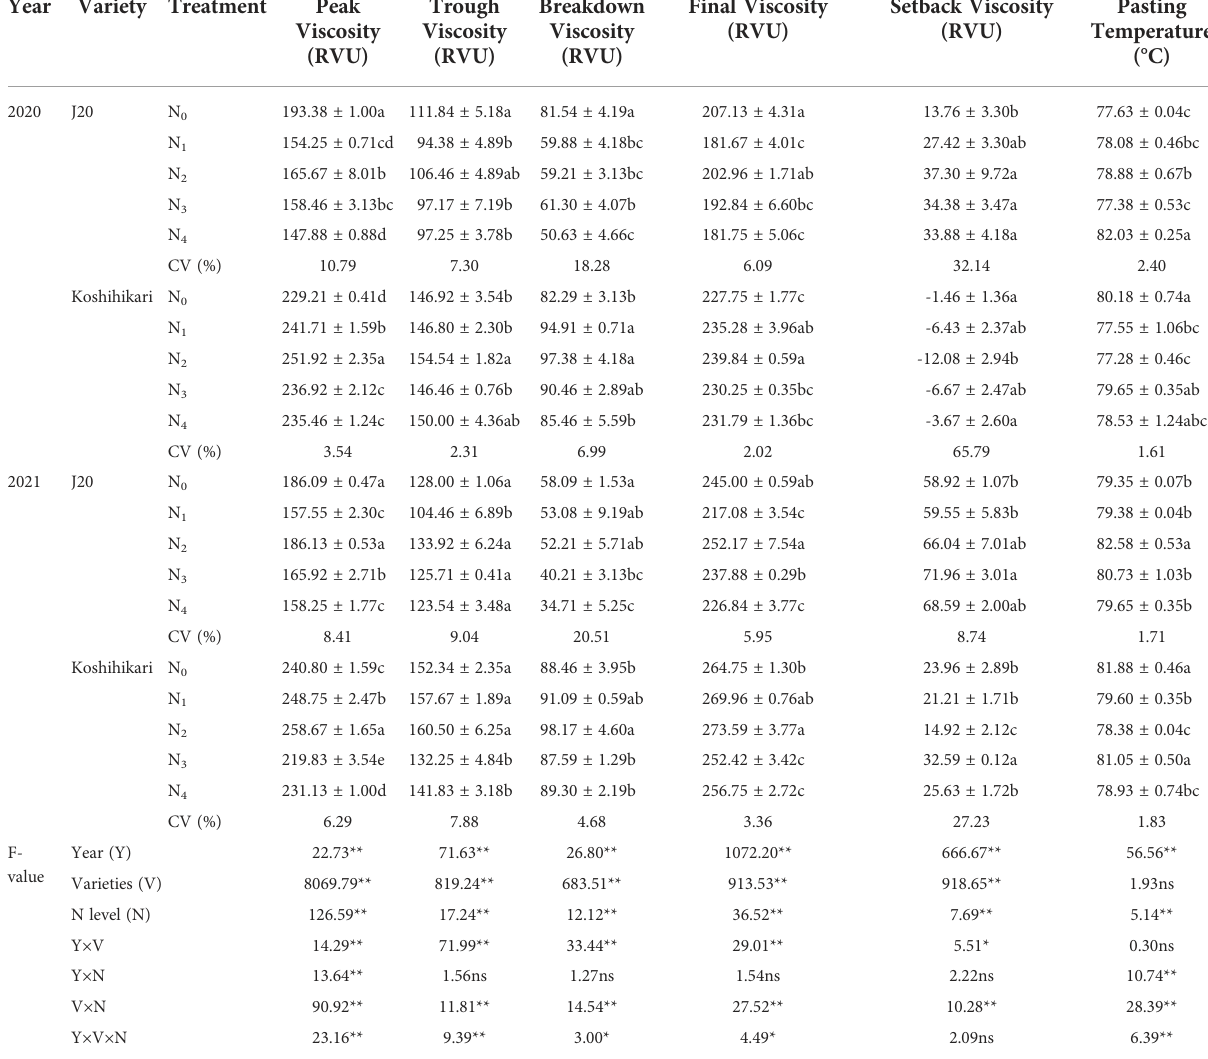
TABLE 4 Effects of N application rate on RVA pro fi le characteristics of brown rice fl our starch. Year Variety